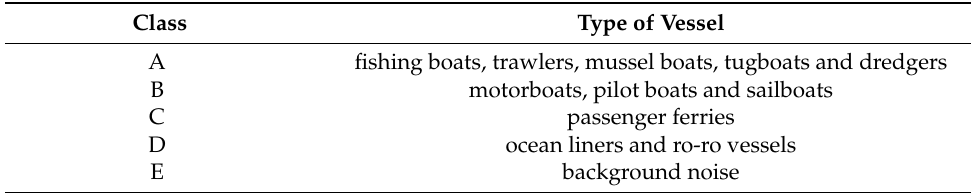
Table 1. The detail of the ShipsEar